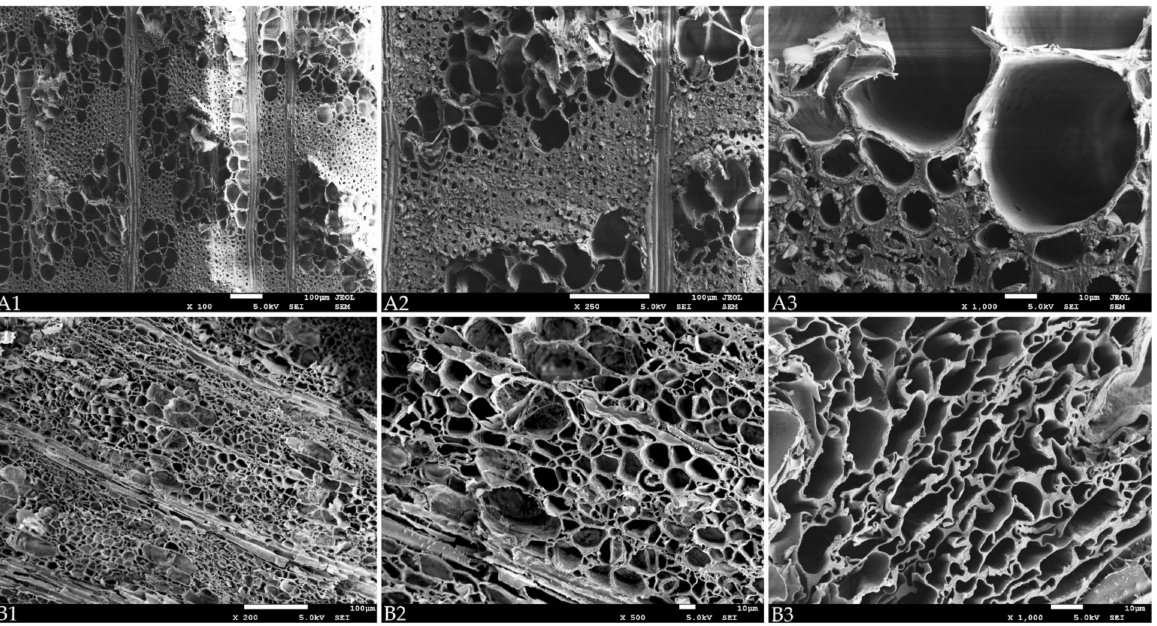
Figure 4. SEM (JEOL 7001F Scanning Electron Microscope (JEOL Ltd., Tokyo, Japan)) images of contemporary elm with undegraded thick cell walls ( A1 – A3 ) and heavily degraded waterlogged elm shrunken upon drying, with very thin and collapsed cell walls consisting mainly of the skeleton of lignin-made middle lamellae ( B1 – B3 ). SRB are a group of prokaryotes that include members of the Bacteria and Archaea domains. SRB reduce sulphate to sulphur when metabolising simple organic